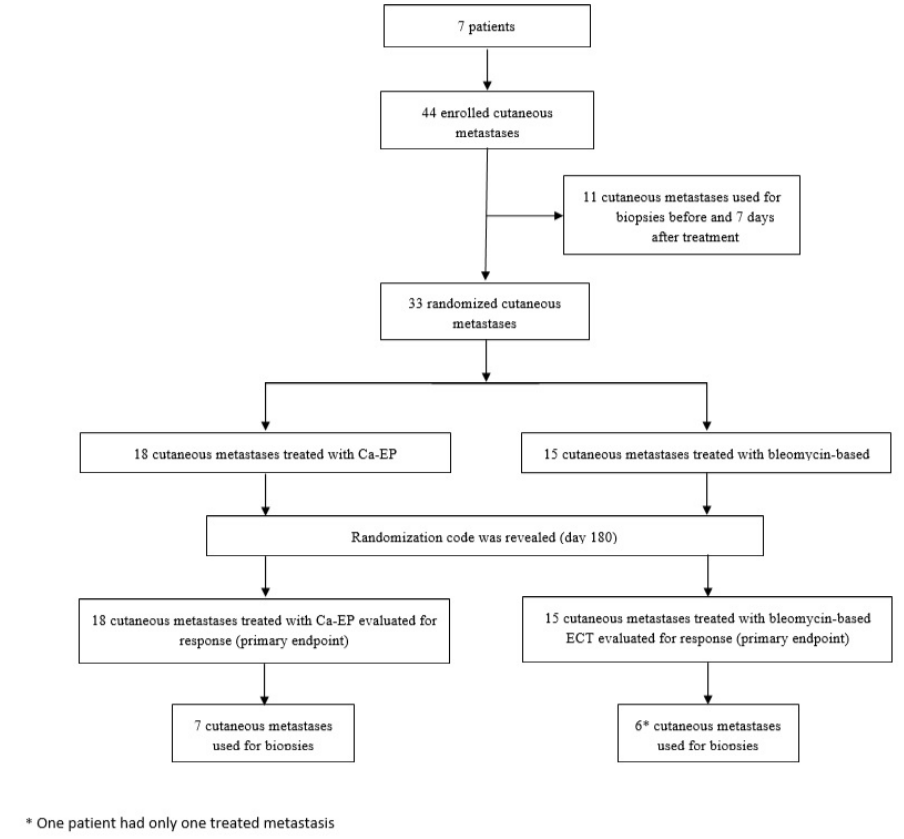
Figure 1. Trial profile. Illustration of trial profile. Further results are described in detail.